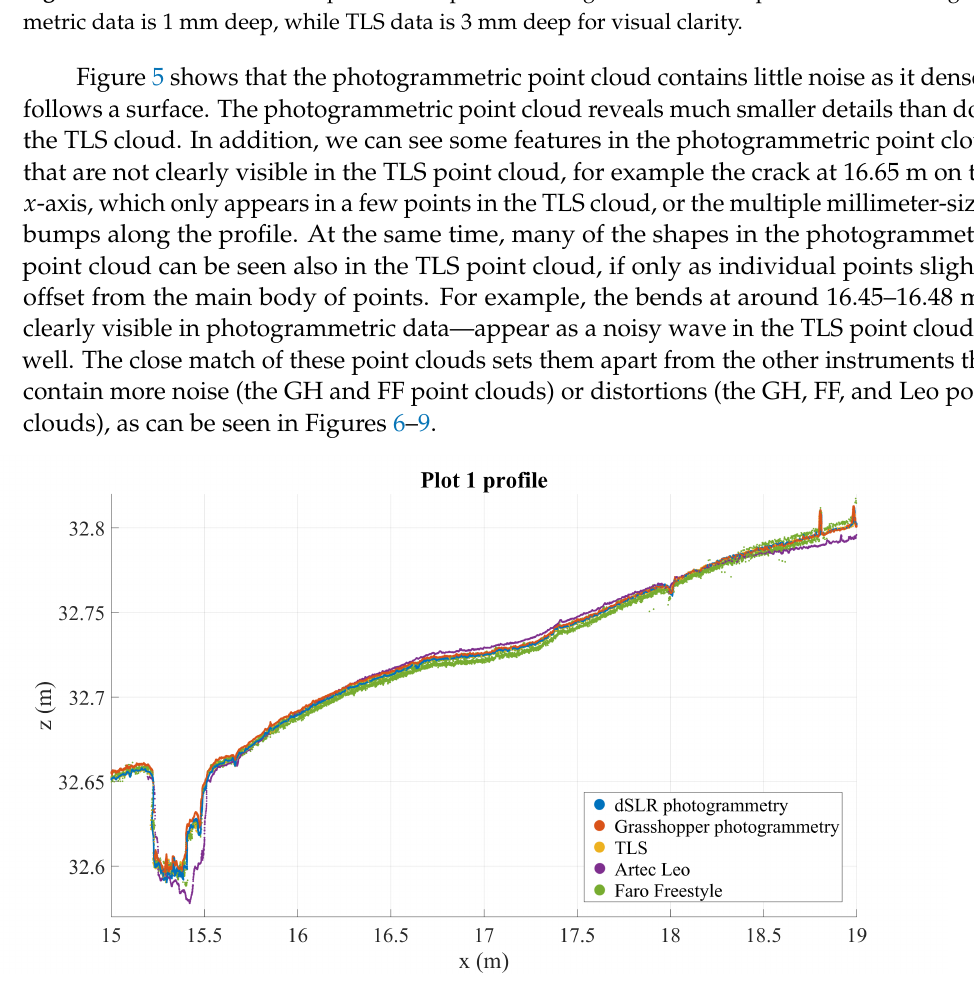
Figure 6. Three mm deep profiles of defect 1 as measured by all instruments in an arbitrary coordinate